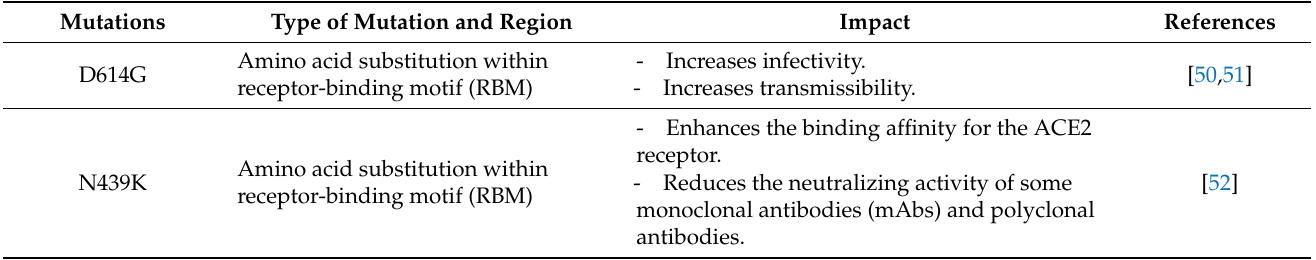
Table 2. Major mutations in the SARS-CoV-2 protein and its impacts.